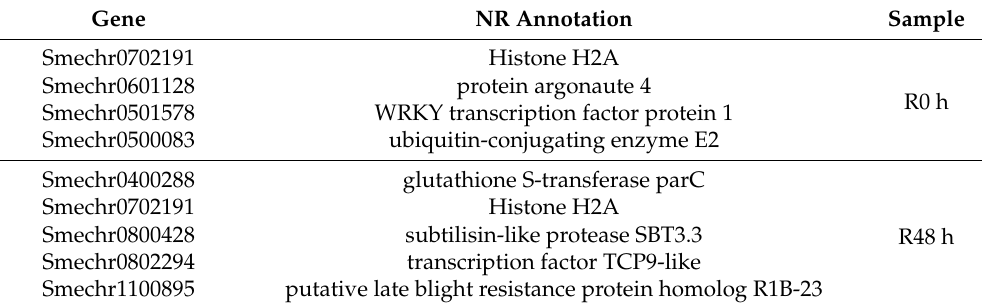
Figure 7. The distance between transcription start sites and MACS peak summits for the gene-associated peaks in R0h and R48h. Table 2. ChIP-seq data reveals peak-associated genes regulated by SmTCP7a. Table 2. ChIP-seq data reveals peak-associated genes regulated by SmTCP7a. Gene